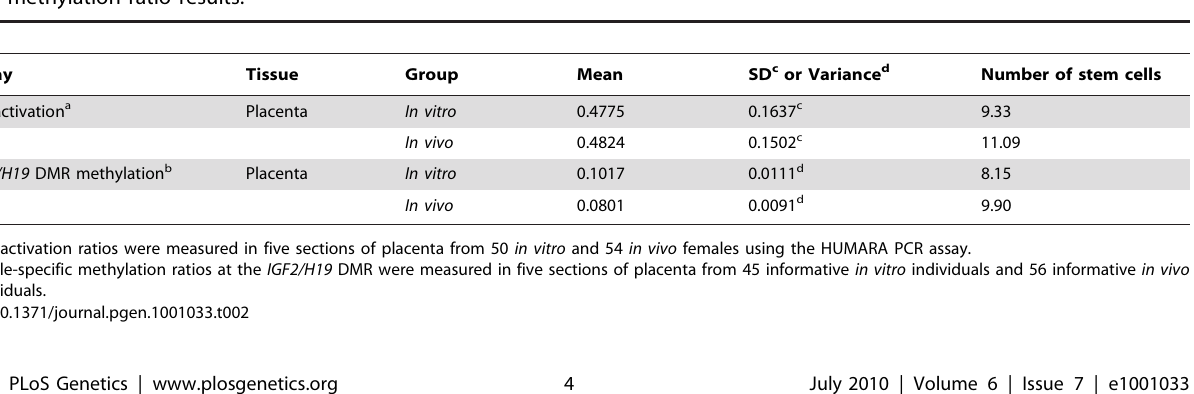
Table 2. Determining number of stem cells by approximating the variance of binomial distribution of X-inactivation and M/P IGF2/ H19 methylation ratio